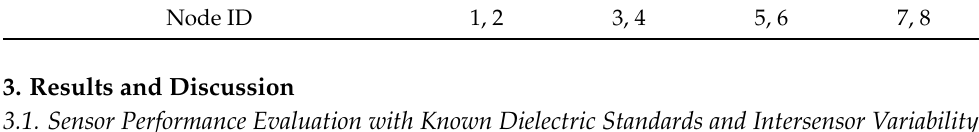
Table 1. Distance from the gateway for each group of sensor nodes. Distance from Gateway (m)